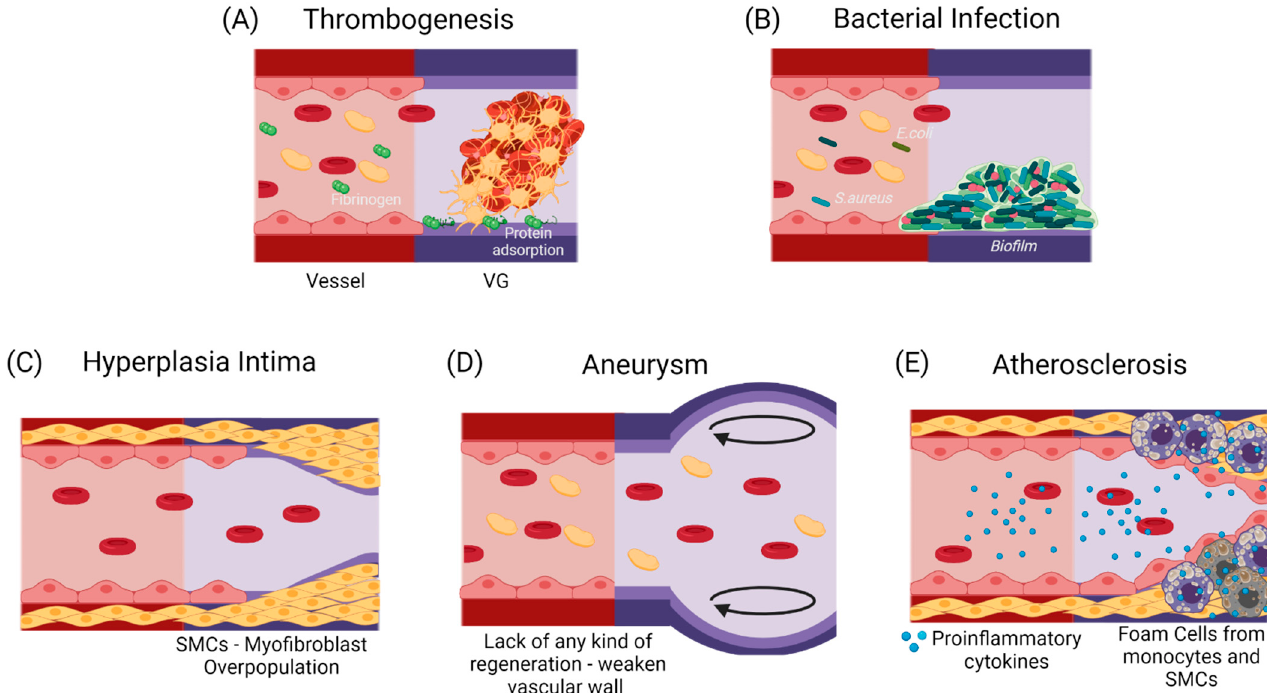
Figure 2. Commonly reported causes for TEVGs’ failure. ( A ) An early failure has been reported to be associated with the inherent thrombogenicity of the biomaterial due to protein adsorption and platelet activation [16]. ( B ) An early failure can also be associated with infection, in which a formed biofilm impairs treatment and induces inflammation [17]. Due to the regulatory mechanisms of endothelium, Mid-Late failure can be mostly related to an incomplete endothelialization. ( C ) an incomplete endothelium and a mismatch in the mechanical properties with a flow disturbance will induce the activation of a synthetic phenotype in SMCs, that will overproliferate and decrease the vessel lumen [17]. ( D ) The lack in the mechanical properties of the TEVG required for specific hemodynamic conditions or a faster biodegradability rate than the vascular wall regeneration is expected to cause aneurysms [18,19]. ( E ) A slower biodegradability rate than the vascular wall regeneration is likely to cause a higher influx of pro-inflammatory cells, that might lead to a dysregulated balance between the synthesis and the degradation of the novo extracellular matrix, and if there is a chronic inflammatory stimulus, atherogenesis can occur with calcium and phosphate deposition in the disorganized tissue [20]. While thrombogenesis and hyperplasia intima have been reported mainly on small ‐ diameter TEVGs, and bacterial infection and aneurysms are typical in larger TEVGs, atherosclerosis has been shown in both types of TEVGs [17]. (Created with BioRender.com, accessed on 7 November 2021).